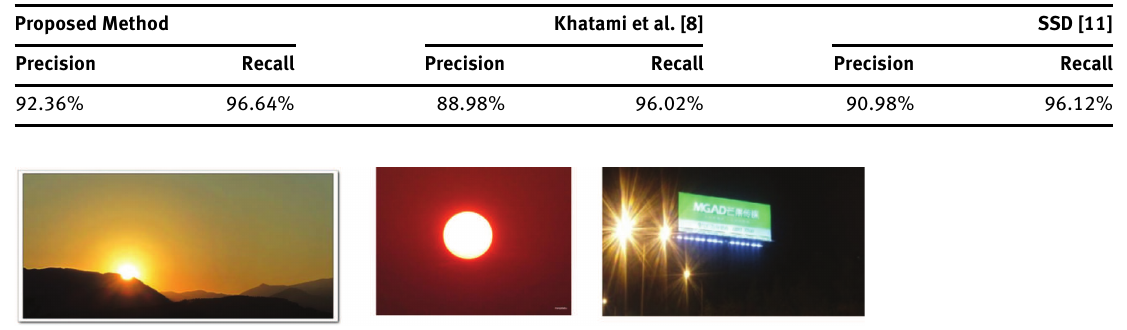
Table 3: Statistical Results.